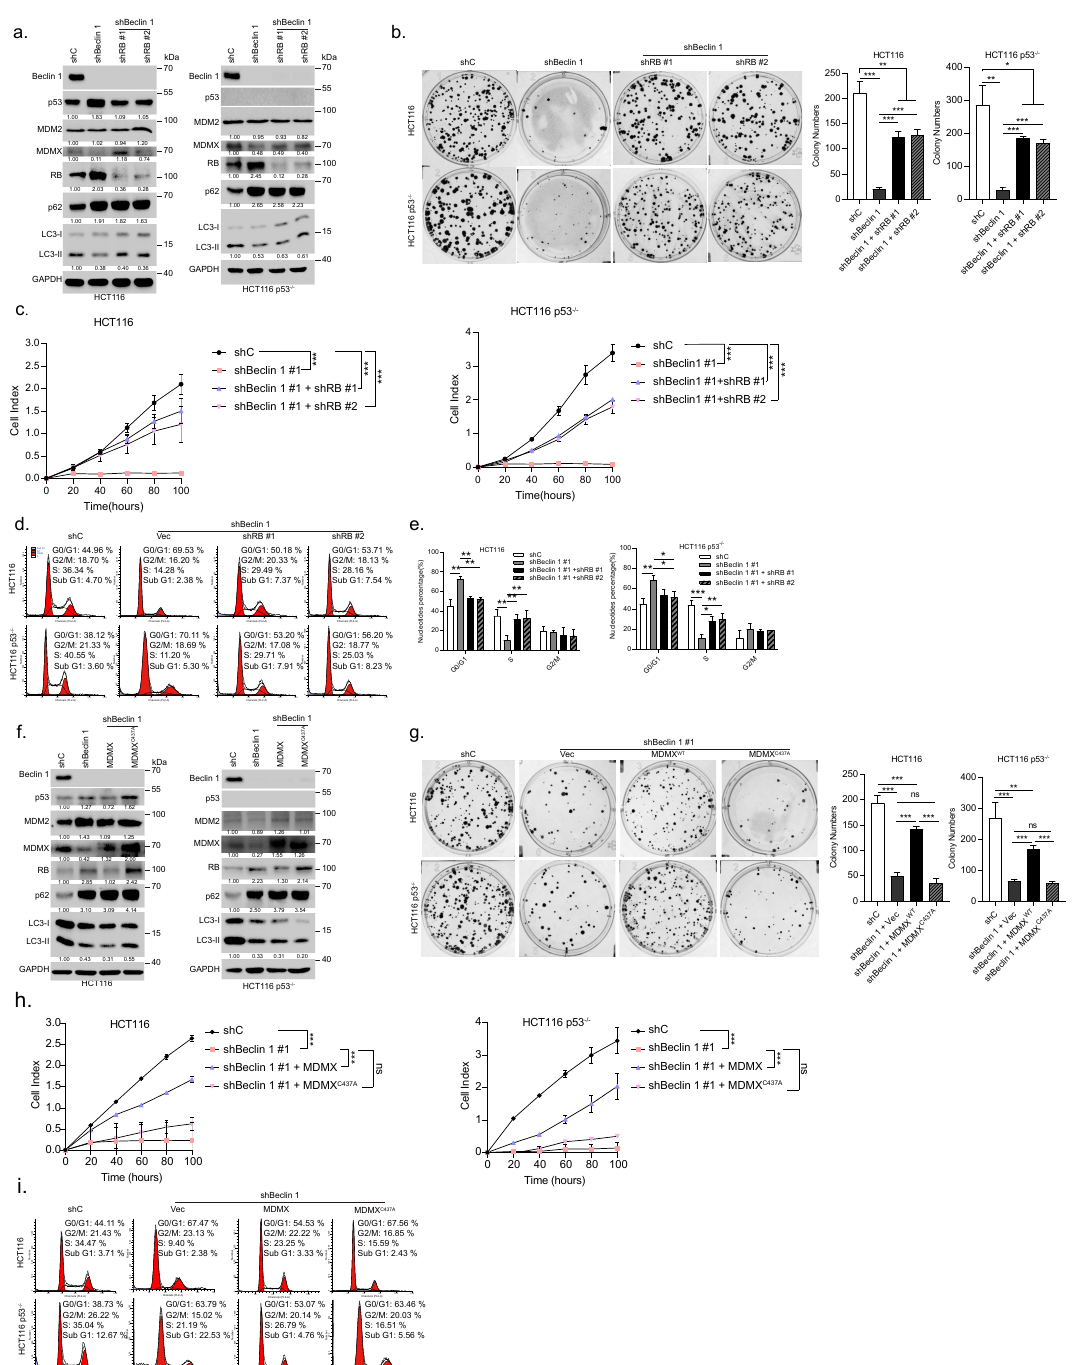
Figure 3. Ablation of BECN1 reduces MDMX expression resulting in the RB-dependent cell cycle G1/S arrest and growth inhibition. HCT116 or HCT116 p53 − / − cells stably expressing shBeclin 1 were infected with lentivirus shRNA specific for RB1 (#1 or #2) or control shRNA and subjected to western blot ( a ), colony formation assays ( b ), real-time cell analyses (RTCA) ( c ), and FACS analyses ( d ). Quantifications of cell cycle derived from FACS analyses ( e ). HCT116 or HCT116 p53 − / − cells stably expressing shBeclin 1 were infected with lentivirus expressing MDMX or MDMX C437A and subjected to western blot ( f ), colony formation assays ( g ), real-time cell analyses (RTCA) ( h ), and FACS analyses ( i ). Data were derived from three independent experiments and were presented as mean ± SD. * p < 0.05, ** p < 0.01, *** p < 0.001. The uncropped blots and molecular weight markers are shown in Supplementary File